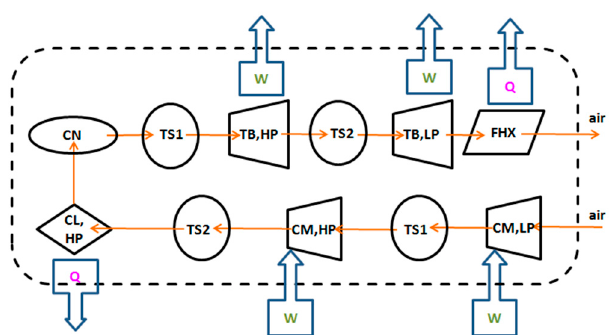
Figure 4. Schematic of the A-CAES system. All of the low pressure (LP) and a portion of the high pressure (HP) compression heat are stored in two thermal storage facilities (TS1 and TS2). The same heat storage units release the heat to the withdrawn compressed air prior to expansion during the discharge phase. “Q” and “W” represent heat and work interactions between the system and the surroundings.